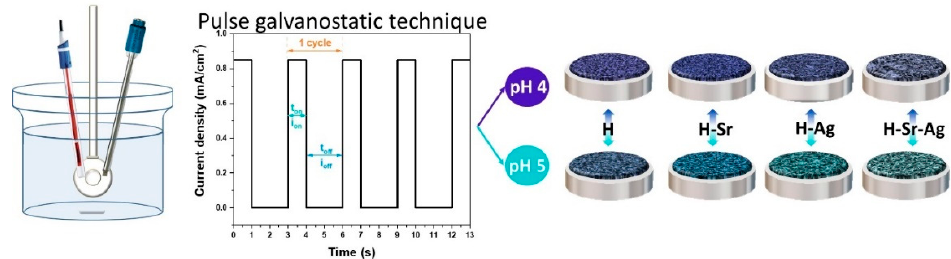
Figure 1. Electrochemical cell configuration and samples codifications.